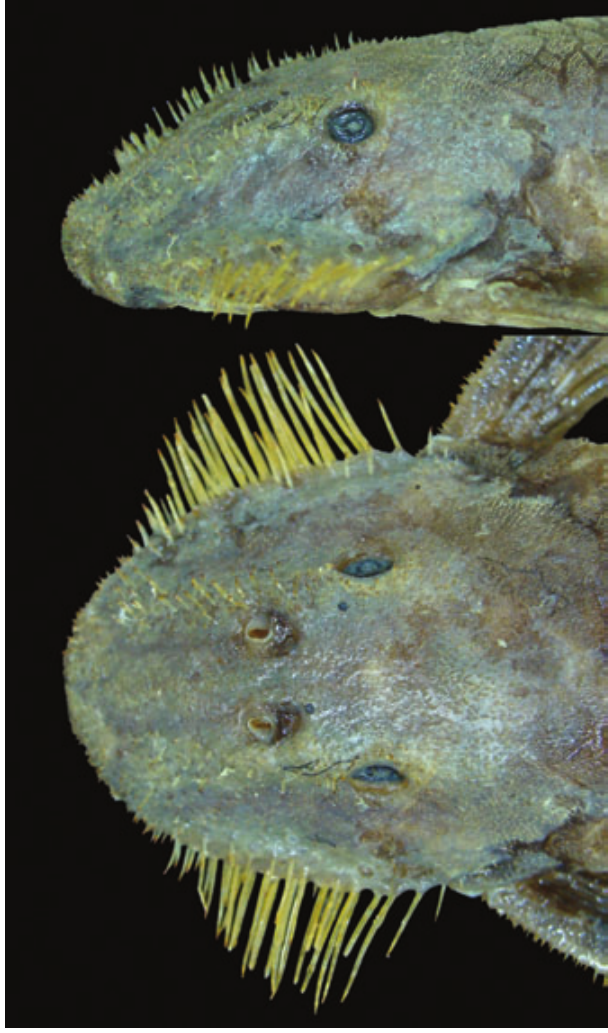
Fig. 4. Pareiorhaphis ruschii , MCP 41811, 98.8 mm SL. Lateral and dorsal views of the head showing development and orientation of hyperthrophied odontodes.